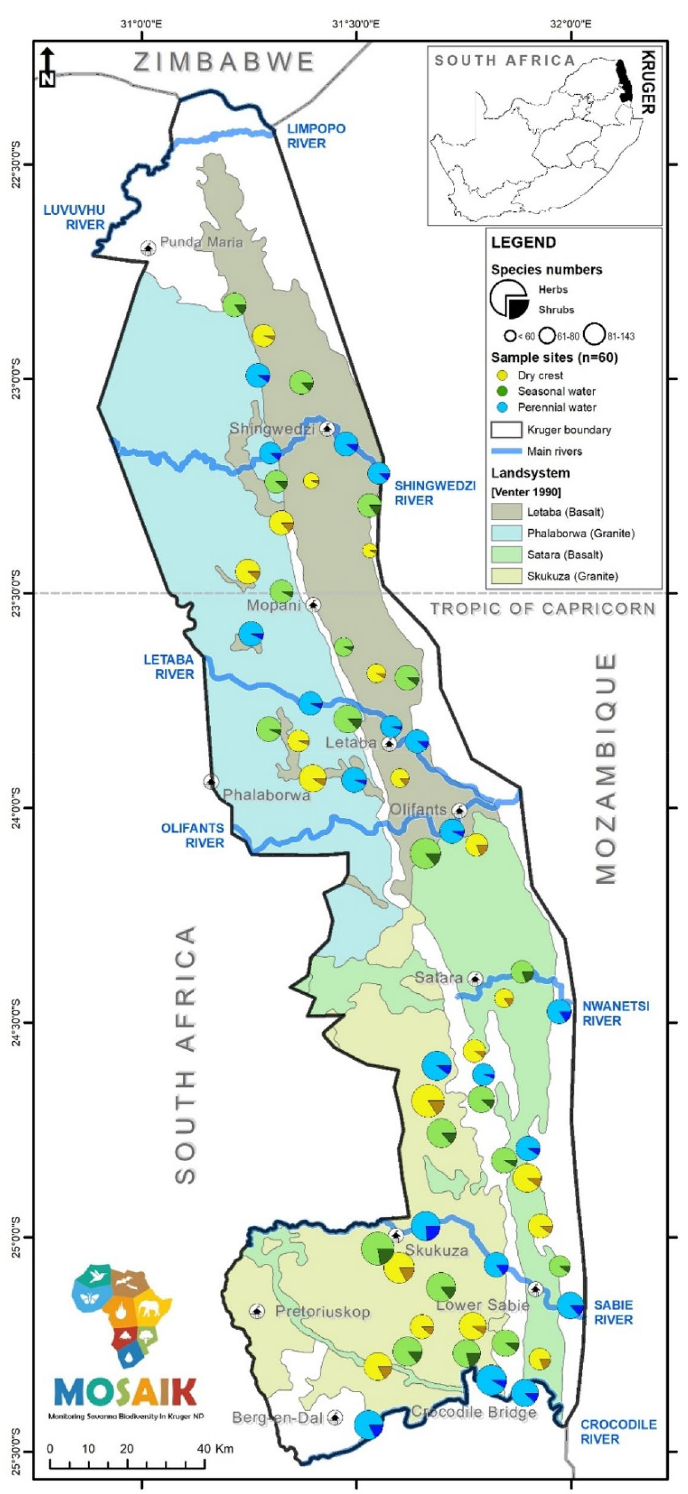
Figure 2. Kruger National Park map with the location of study plots across habitats (dry crest, seasonal river, perennial river) and bedrocks (basalt and granite), reflecting the four most represented landsystems. The total plant species richness in a plot (per 2500 m 2 ) and the proportion accounted for by herbs (including grasses) and shrubs is indicated by the size of the circle and shade of the colour, respectively. The figure was created using ArcGIS Desktop, Release 10.4 (Redlands 2011, https:// www. esri.